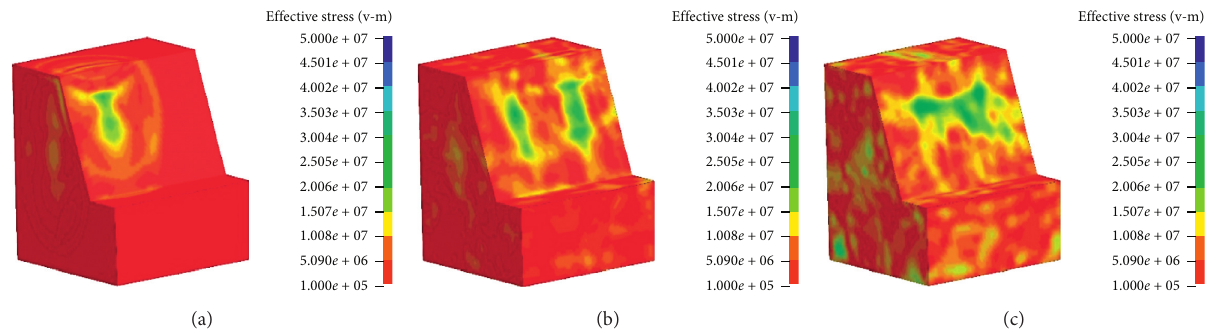
Figure 12: 13m × 6m effective stress of the section between the front holes at different times. (a) t � 1.99 ms. (b) t � 43.49ms. (c) t � 144.00ms.